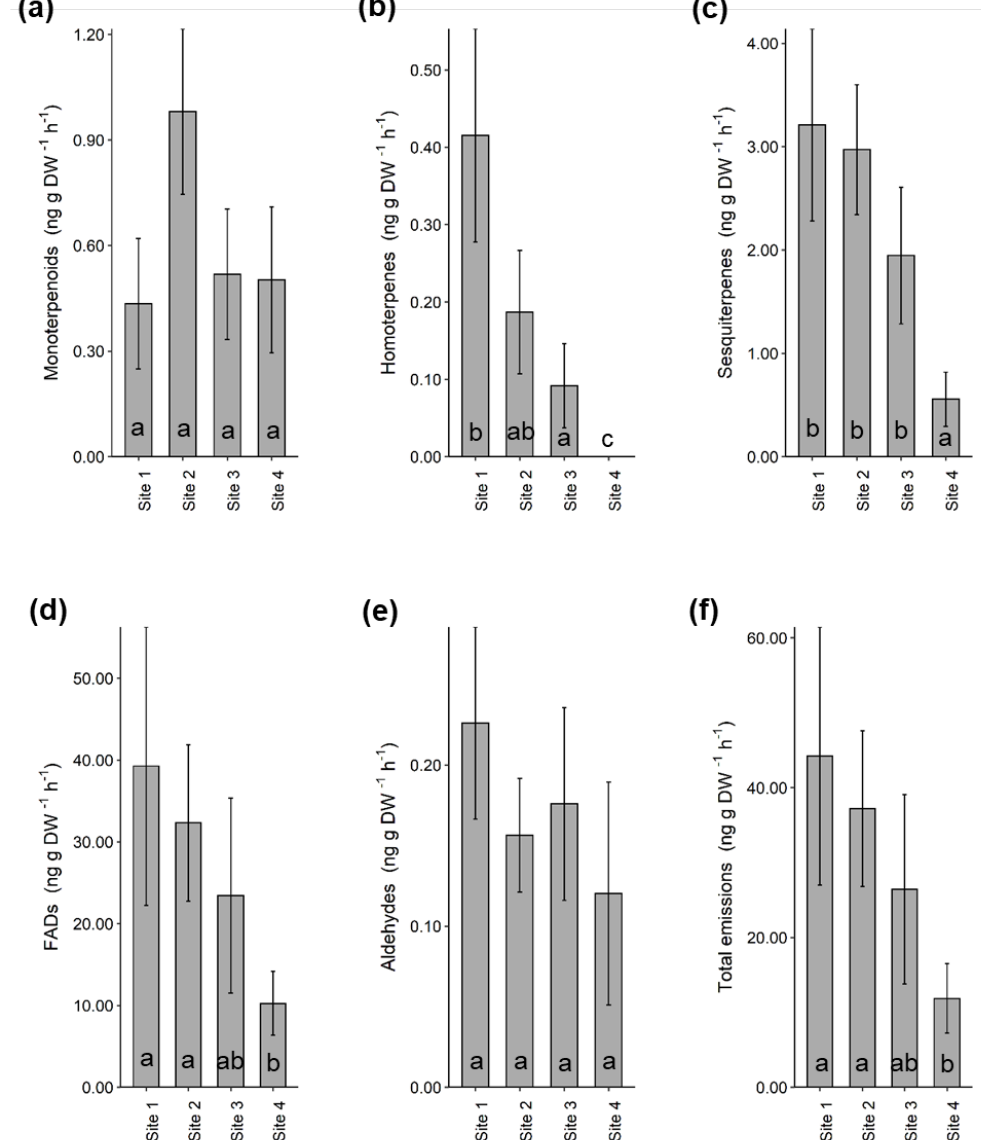
Figure 2. Volatile organic compound (VOC) classes identified from the headspace of heather at four di ff erent sites. Bars show mean ± SE of total ( a ) monoterpenoids, ( b ) homoterpenes, ( c ) sesquiterpenes, ( d ) fatty acid derivatives, ( e ) aldehydes and ( f ) total volatile emissions measured from target plants from each site (n = 5). Letters indicate pairwise comparisons between sites. Abbreviations: fatty acid derivatives (FADs).